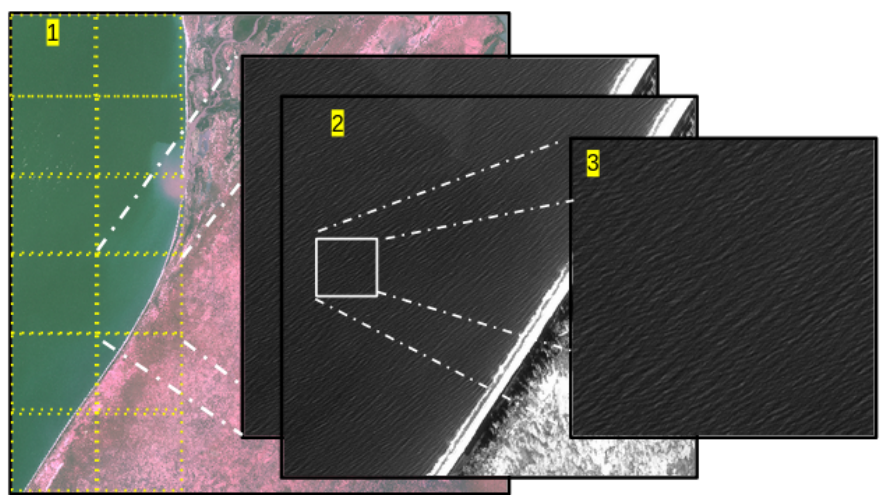
Figure 2. (1). Description of the manner by which the slicing is performed depending on the number of CPUs. (2). Creating a sub-window over the point of interest. (3). The sub-window where the different variables (e.g., celerity and depth) are computed.